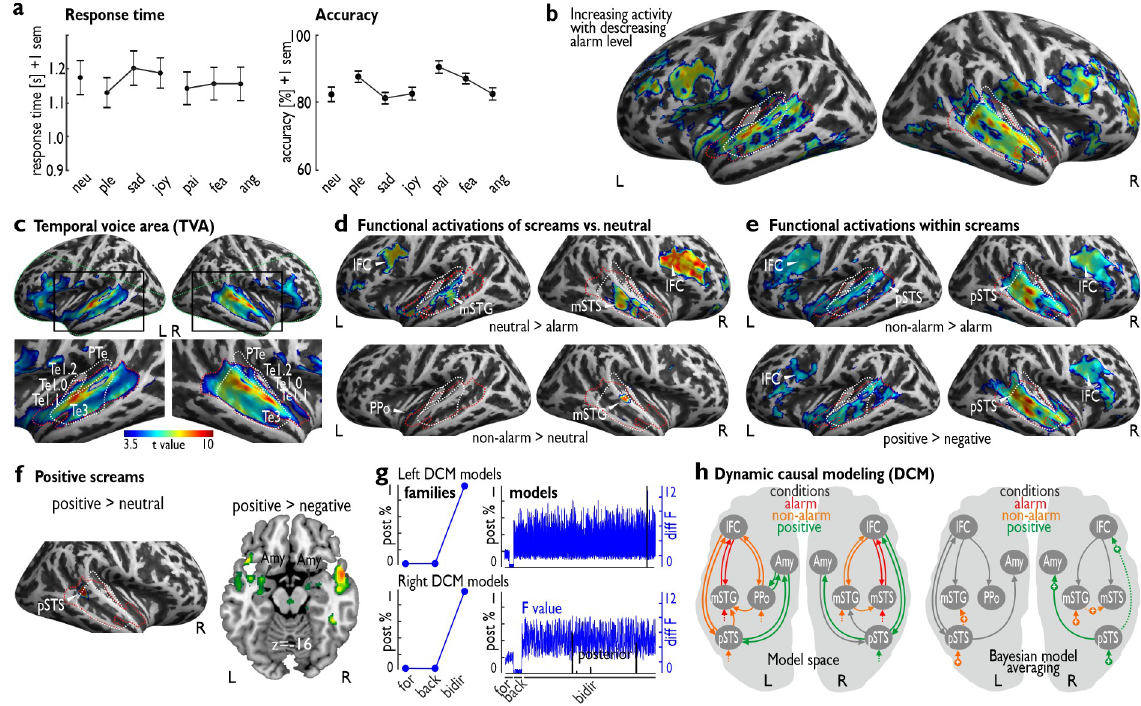
Fig 3. Neural activity and effective functional network for scream call processing. (a) Behavioral data from the gender task during the functional magnetic resonance imaging (fMRI) experiment (experiment 4); shown are the response times (left) and the accuracy level (right) for performing a gender decision task on the screams perceived during the fMRI experiment ( n = 30). (b) Negative parametric modulation of brain activity by the alarm rating of scream calls; while we did not find neural activity for a positive relationship with the alarm ratings of every scream, we found largely extended activity in the auditory cortex and the frontal cortex for negative associations with the alarm level of each scream. (c) Functional definition of the temporal voice area (TVA) in n = 30 human participants. The red dashed line indicates the cortical extension of the TVA; the green dashed line indicates the coverage of the partial volume acquisition; the white dashed line defines the anatomical subregions of the auditory cortex (primary areas Te1.0, Te1.1, Te1.2, and secondary area Te3) and the planum temporale (PTe). (d) Alarm screams compared with neutral screams ( n = 30) elicited reduced activity in the bilateral IFC and STC (left mSTG, right mSTS), whereas non-alarm screams elicited increased activity in the bilateral STC (left PPo, right mSTG). (e) Compared with alarm screams, non- alarm screams elicited significantly higher and extended activity in the bilateral IFC and STC. (f) Positive screams (pleasure, joy) showed higher activity in the right pSTS compared with that for neutral screams and in the bilateral amygdala compared with that for negative screams (sadness, pain, fear, anger). (g) Dynamic causal modeling (DCM) revealed the bidirectional model family as the winning family based on the posterior probability (left panel) in both the left (top left) and right hemispheres (bottom left). The right panel shows the posterior probabilities (black) and the log-evidence (blue; “diff F” = F -value minus the minimum F -value across models) for each model from the forward (for), backward (back), and bidirectional (bidir) model families. (h) Bayesian model averaging in the bidirectional model family indicated specific significant modulation of the left ( n = 28) and right hemisphere ( n = 28) only in the non-alarm (orange) and positive (green) scream conditions (see S3 Table). All activations are thresholded at p = 0.005 voxel level and a minimum cluster size of k = 42, resulting in a corrected threshold of p = 0.05 at the cluster level. Numerical data underlying the plots in (a) can be found in S3 Data and S3 Table. Amy, amygdala; ang, anger; fea, fear; IFC, inferior frontal cortex; L, left; mSTG, middle superior temporal gyrus; mSTS, middle superior temporal sulcus; neu, neutral; pai, pain; ple, pleasure; PPo, planum polare; R, right; pSTS, posterior superior temporal sulcus; sad, sadness; sem, standard error of the mean; STC, superior temporal